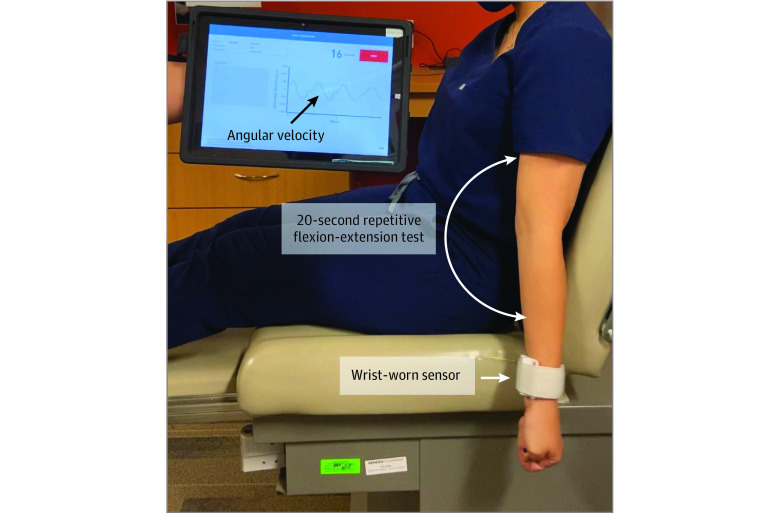
Frailty Assessment by Upper Extremity Motion Using Frailty MeterThe system, which consists of a sensor worn on the wrist and a wirelessly connected tablet, records angular velocity during a 20-second repetitive elbow flexion-extension task, and then displays a frailty score. All measurements were done in the clinics or in the preprocedure holding area of the catheterization laboratory within 1 week before the revascularization.